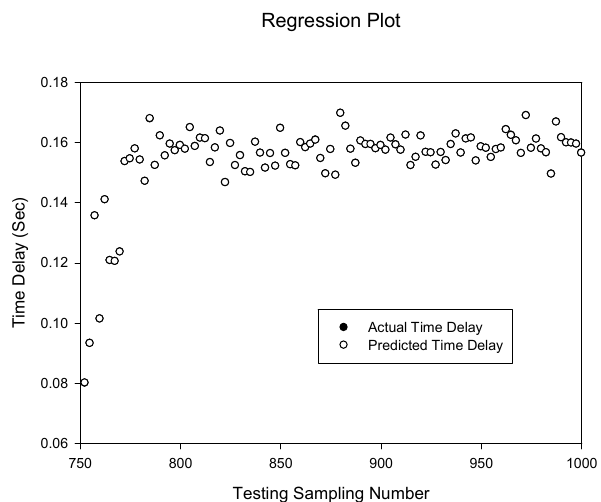
Testing Sampling Number